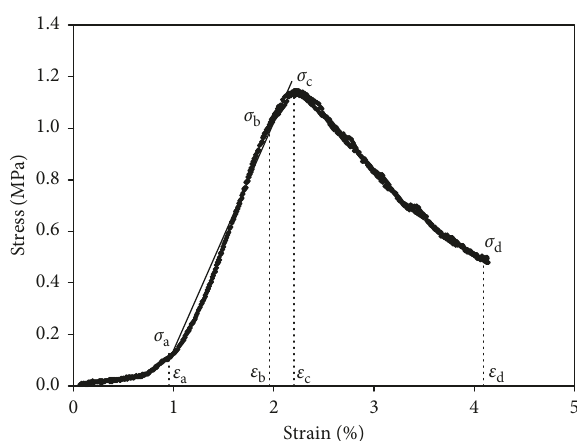
Figure 7: Relationship between the accumulative energy and loading time with different waste concrete substitutions. Figure 6: Stress-strain curve of